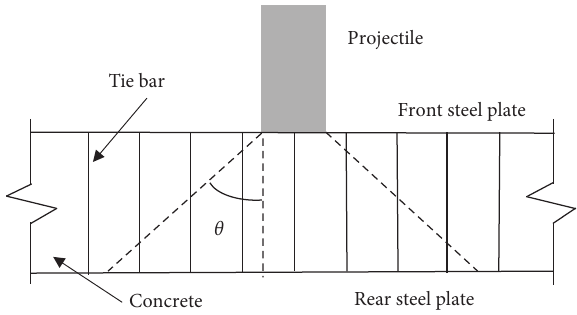
Figure 1: SCS wall with tie bars against projectile